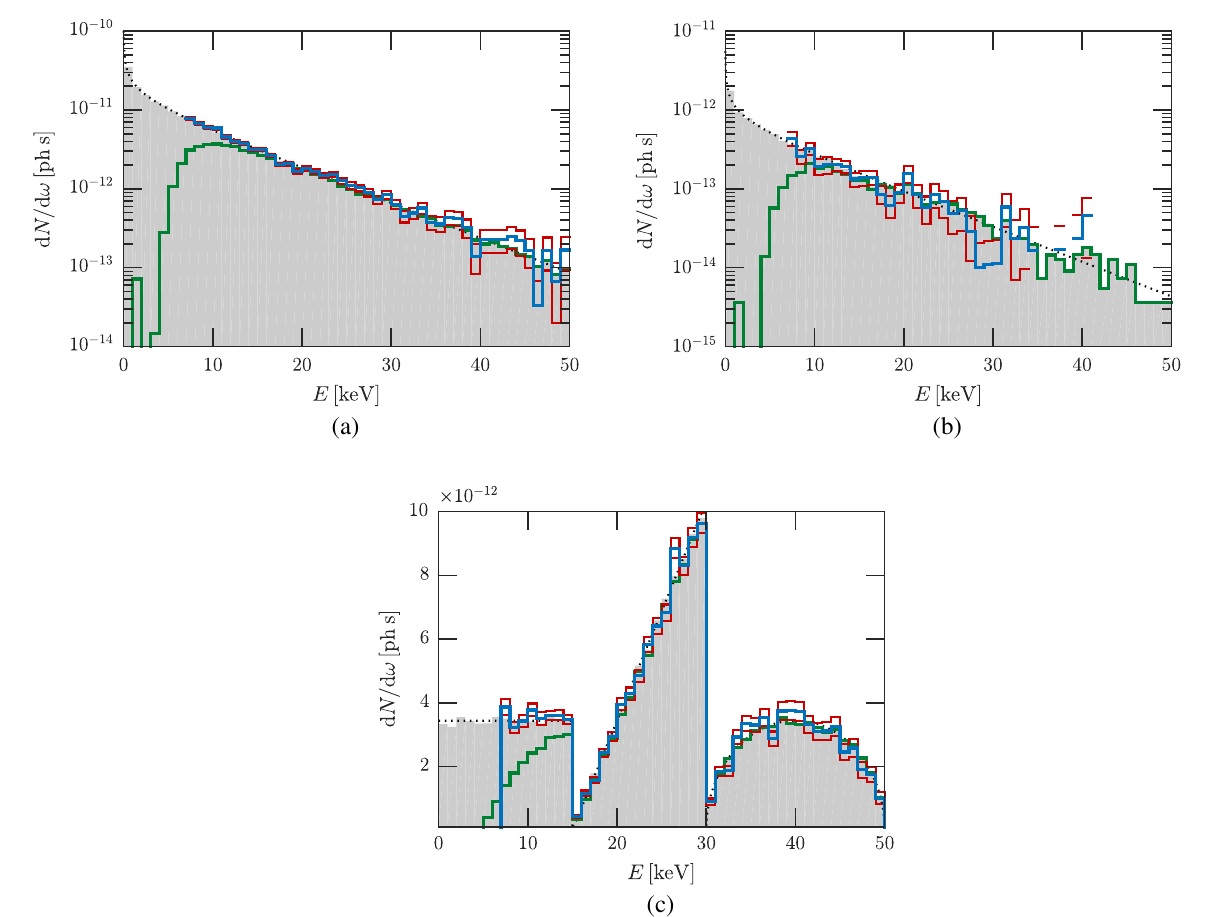
FIG. 3. Comparison of the incident and retrieved (blue) spectra for the case of diffraction by powdered silicon; for the incident beam, the underlying spectrum is shown by the dashed black line and that of the sample generated by the Monte-Carlo code is shown by the gray bins. (a) and (b) show the spectra for an incident beam with a synchrotron spectrum with E (a) 1 . 2 × 10 8 photons; (b) 6 . 0 × 10 6 photons. Shown in (c) are the incident and deduced spectra for a beam of 1 . 2 × 10 8 photons with a complex spectrum. For all plots the spectrum of the beam transmitted through the powder sample is shown in green, and the error bars (red) are calculated assuming the number of photons detected within each energy bin follows a Poisson